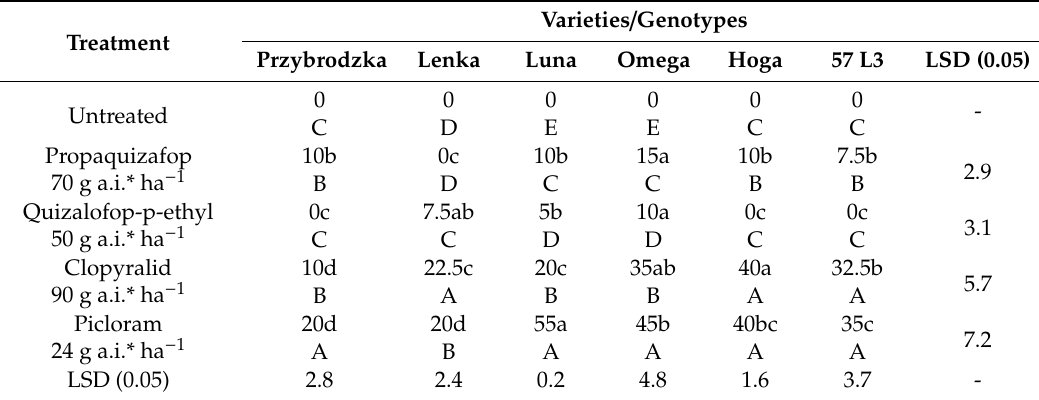
Table 1. Visual assessment of phytotoxicity (%) 21 days after treatment (21 DAT).